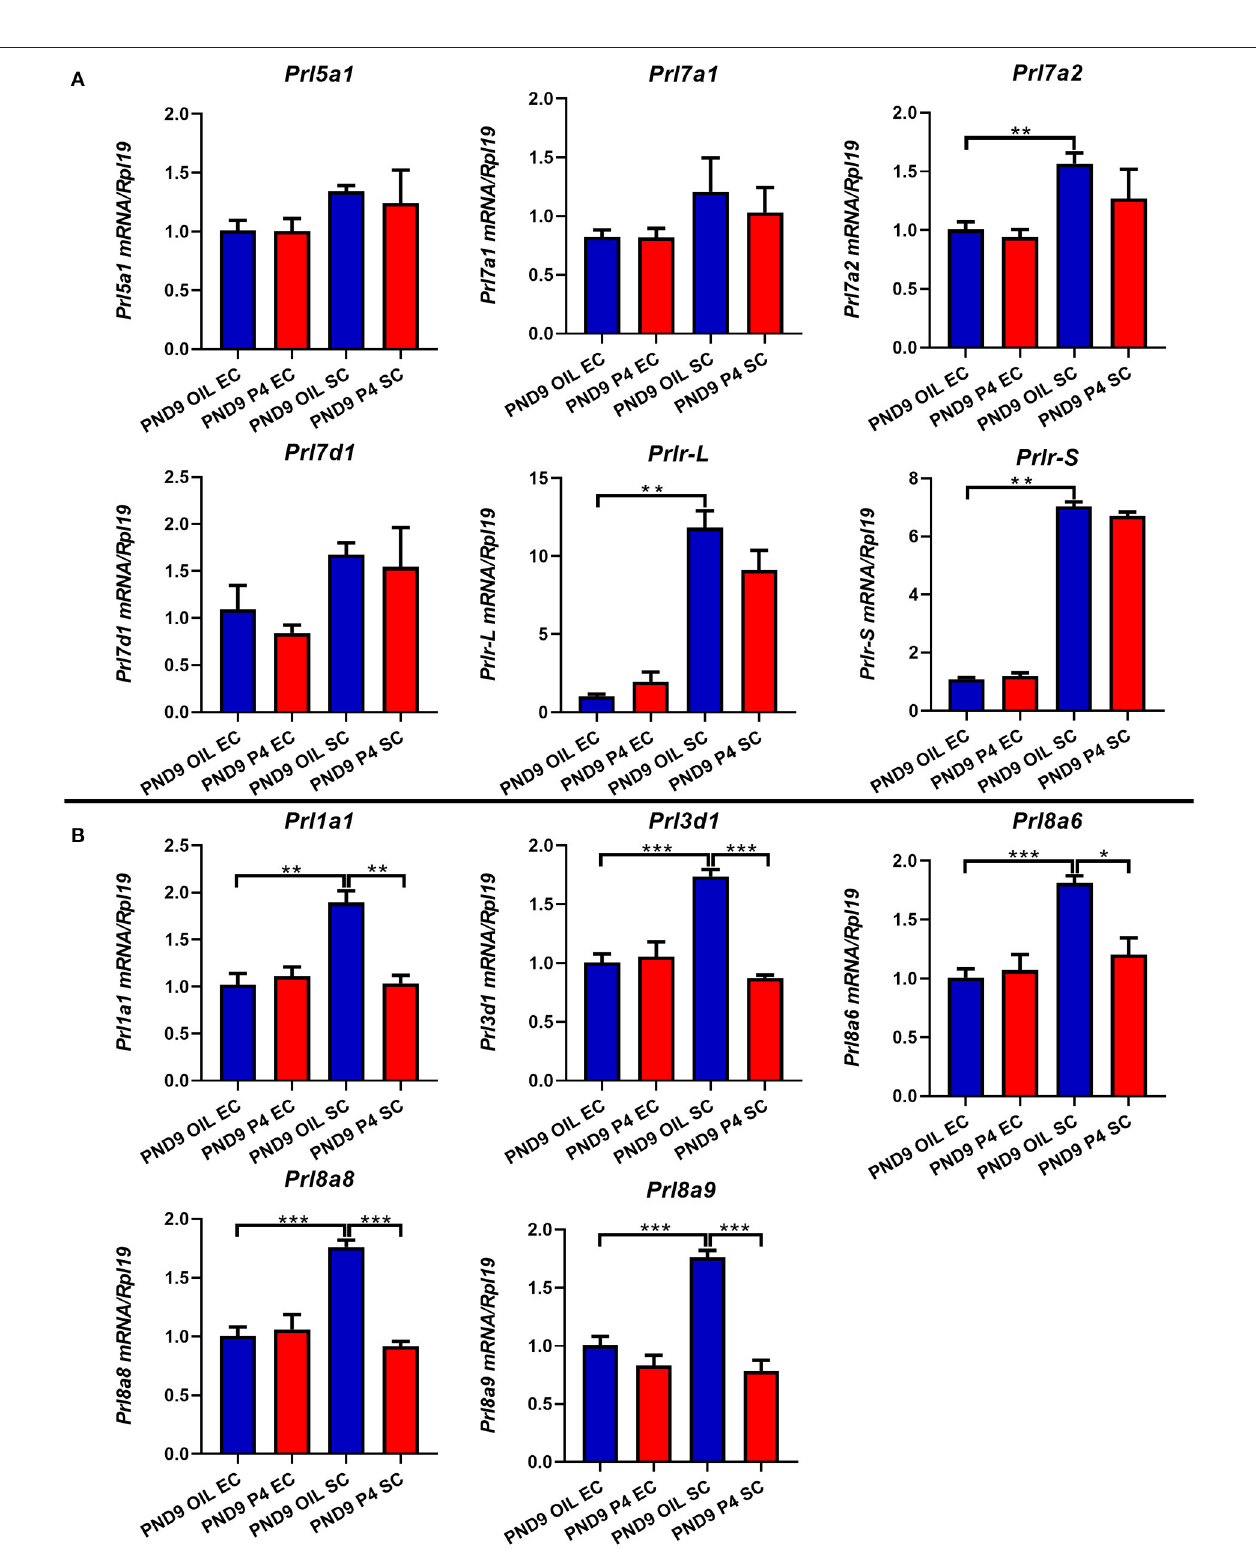
FIGURE 7 | Quantitative Real-time-PCR analysis of Prl1a1 , Prl3d1 , Prl5a1 , Prl7a1 , Prl7a2 , Prl7d1 , Prl8a6 , Prl8a8, Prl8a9 , and Prlr ( Prlr-L and Prlr-S ) mRNA levels in epithelium or stroma on PND9. The expression level of Prl5a1 , Prl7a1 , Prl7a2 , Prl7d1, and Prlr ( Prlr-L and Prlr-S ) returned to normal on PND9 (A) . Prl1a1 , Prl3d1 , Prl8a6 , Prl8a8 , and Prl8a9 were significantly inhibited in the endometrial stroma on PND9 (B) . Results are means ± SEM ( n = 5). Bars with different superscripts are significantly different ( P < 0.05).